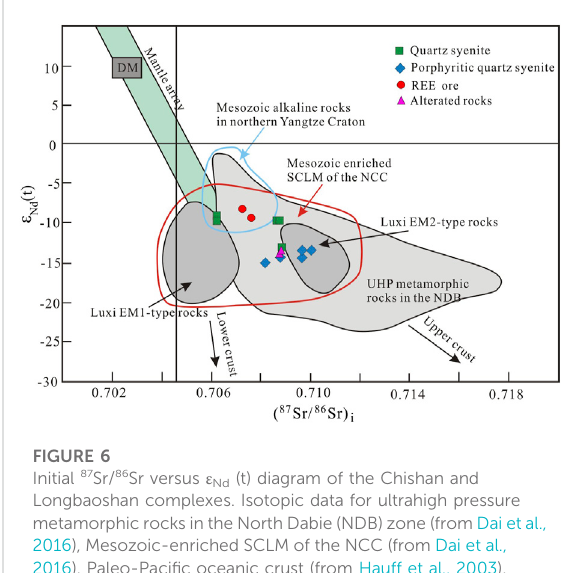
FIGURE 6 Initial 87 Sr/ 86 Sr versus ε Nd (t) diagram of the Chishan and Longbaoshan complexes. Isotopic data for ultrahigh pressure metamorphic rocks in theNorth Dabie (NDB) zone(from Dai